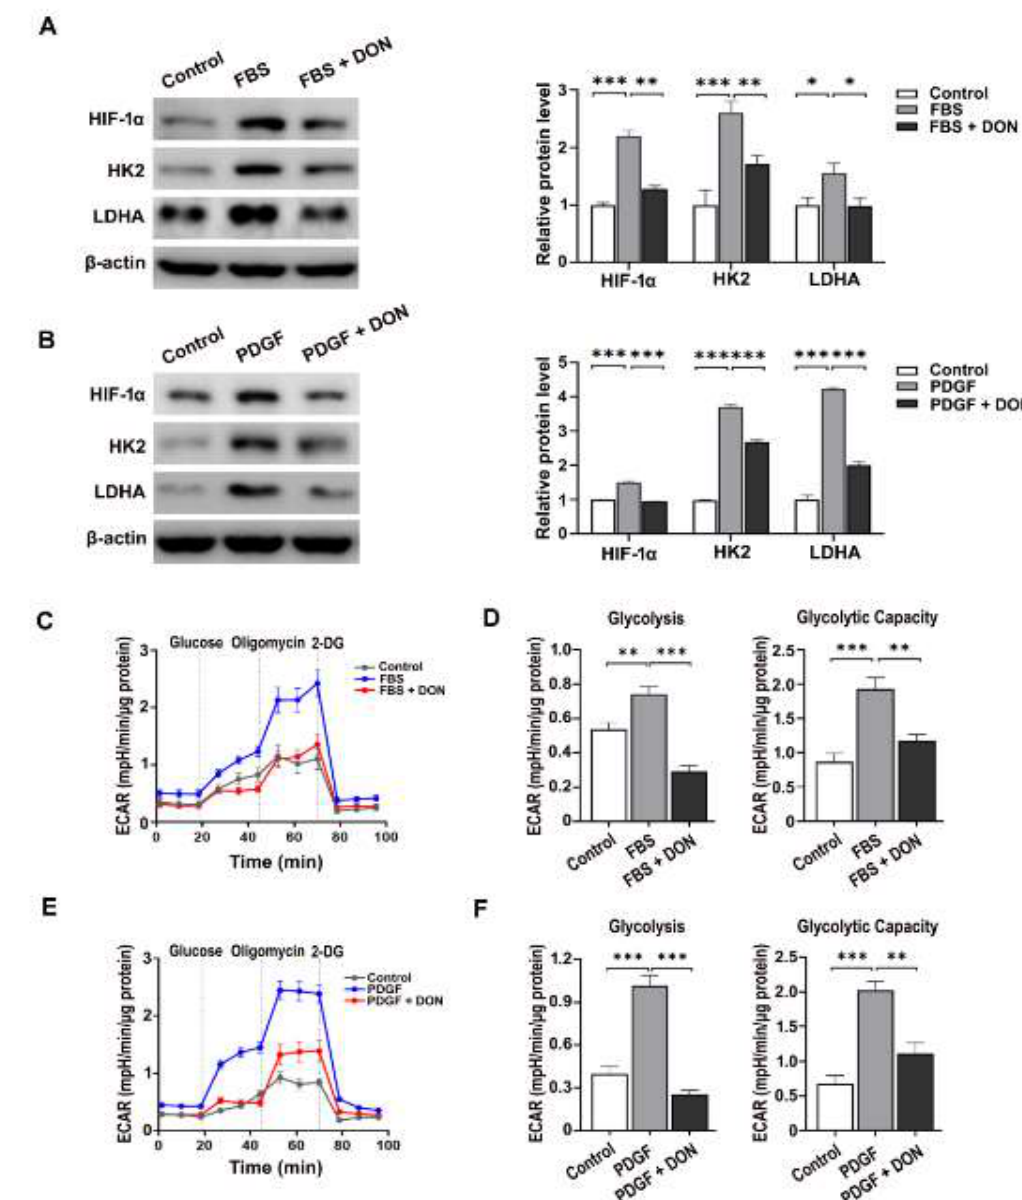
Figure 3. DON suppresses glycolysis in growth factor-stimulated VSMCs. ( A ) and ( B ) Representative western blots showing the effects of DON on the levels of HIF-1 α , HK2, and LDHA in VSMCs stimulated with FBS ( A ) and PDGF ( B ). Data in bar graphs are mean ± SEM of three independent measurements. ( C )–( F ) The ECAR in FBS- and PDGF-stimulated VSMCs. ECAR kinetic traces and the glycolytic rate and glycolytic capacity of FBS ( C ) and ( D )- and PDGF ( E ) and ( F )- stimulated VSMCs treated with or without DON. Data are expressed as the mean ± SEM ( n = 3 technical replicates). * p < 0.05, ** p < 0.01, and *** p < 0.001.